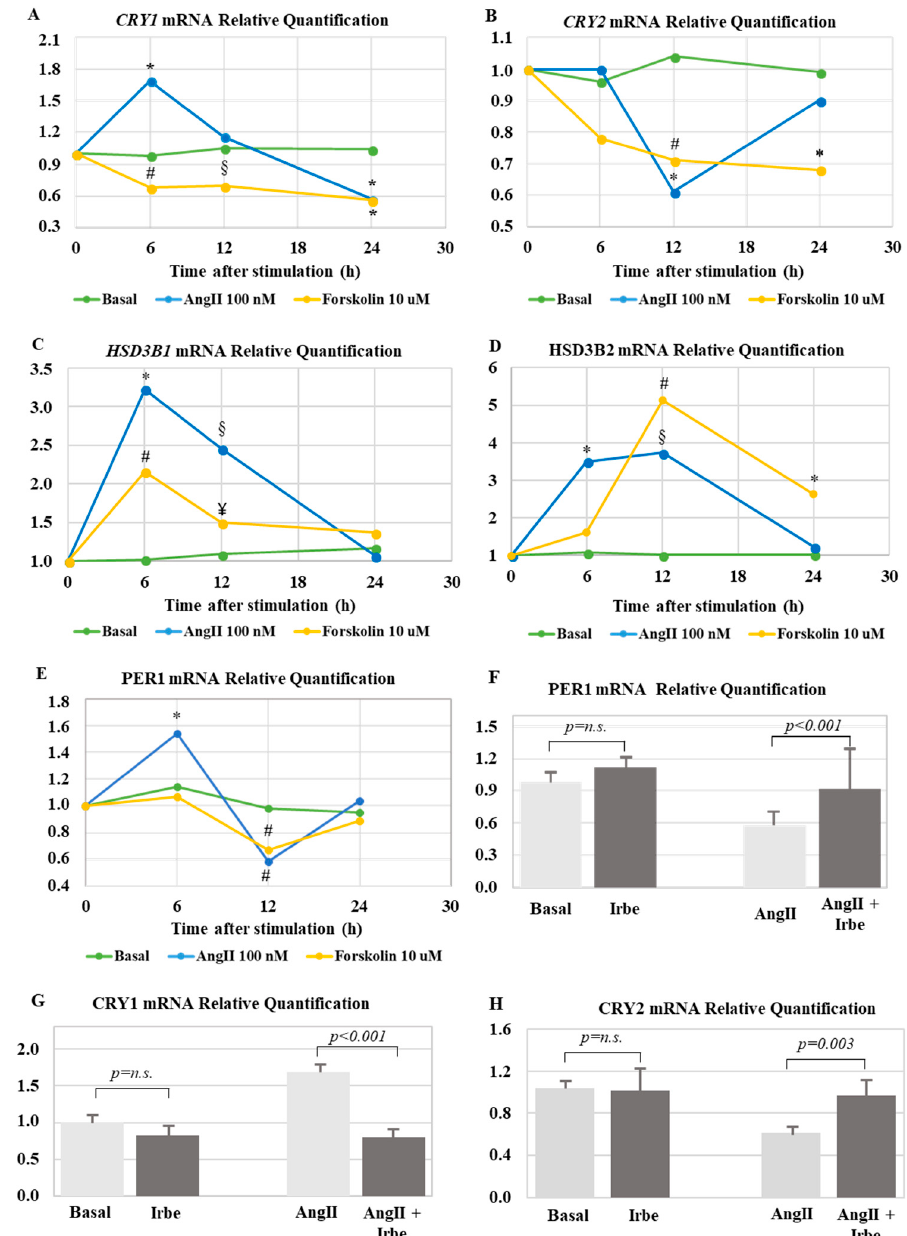
Figure 4. ( A ) Real-time PCR analysis of CRY1 gene expression. * p -Value < 0.001, # p -value = 0.007, and § p -value = 0.017 when compared with basal. ( B ) Real-time PCR analysis of CRY2 gene expression. * p -value < 0.001 and # p -value = 0.003 when compared with basal. ( C ) Real-time PCR analysis of HSD3B1 gene expression. * p -value = 0.022, # p -value = 0.03, § p -value < 0.001, and ¥ p -value = 0.023 when compared with basal. ( D ) Real-time PCR analysis of HSD3B2 gene expression. * p -value < 0.001, # p -value = 0.001, and § p -value = 0.009 when compared with basal. ( E ) Real-time PCR analysis of period ( PER1 ) gene expression. * p -value = 0.001 and # p -value < 0.001 when compared with basal. ( A – E ) Each point expresses the mean fold change over basal expression in at least three independent experiments. ( F ) Real-time PCR analysis of PER1 gene expression at 6 h, after stimulation with 100 nM AngII ± 1 µ M irbesartan. ( G ) Real-time PCR analysis of CRY1 gene expression at 6 h, after stimulation with 100 nM AngII ± 1 µ M irbesartan. ( H ) Real-time PCR analysis of CRY2 gene expression at 12 h, after stimulation with 100 nM AngII ± 1 µ M irbesartan. ( F – H ) Each bar represents the mean ± SD of relative fold change of gene expression in three independent experiments.